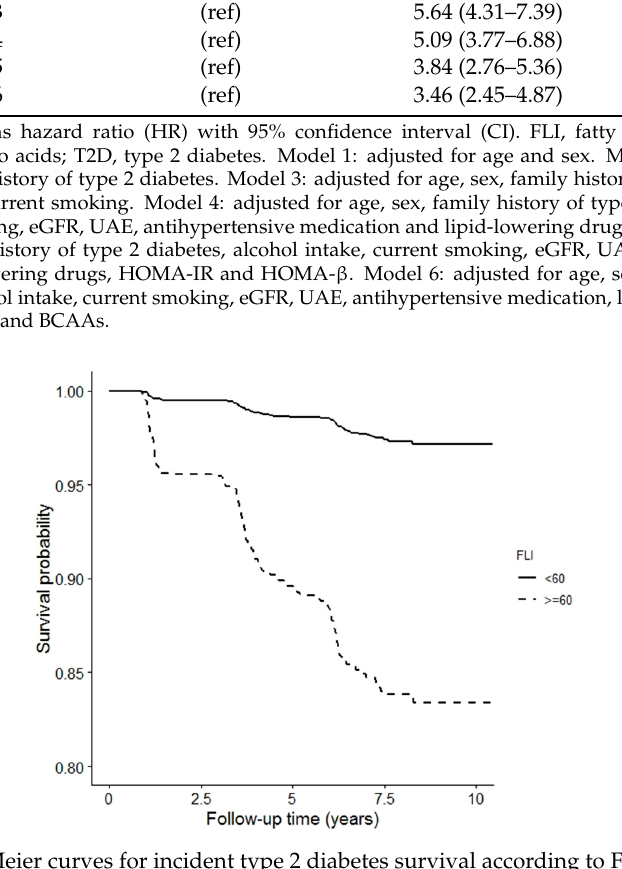
Figure 1. Kaplan–Meier curves for incident type 2 diabetes survival according to FLI score. Log-rank test ( p < 0.001). FLI, fatty liver index. Table 3. Prospective associations of FLI with incident type 2 diabetes.